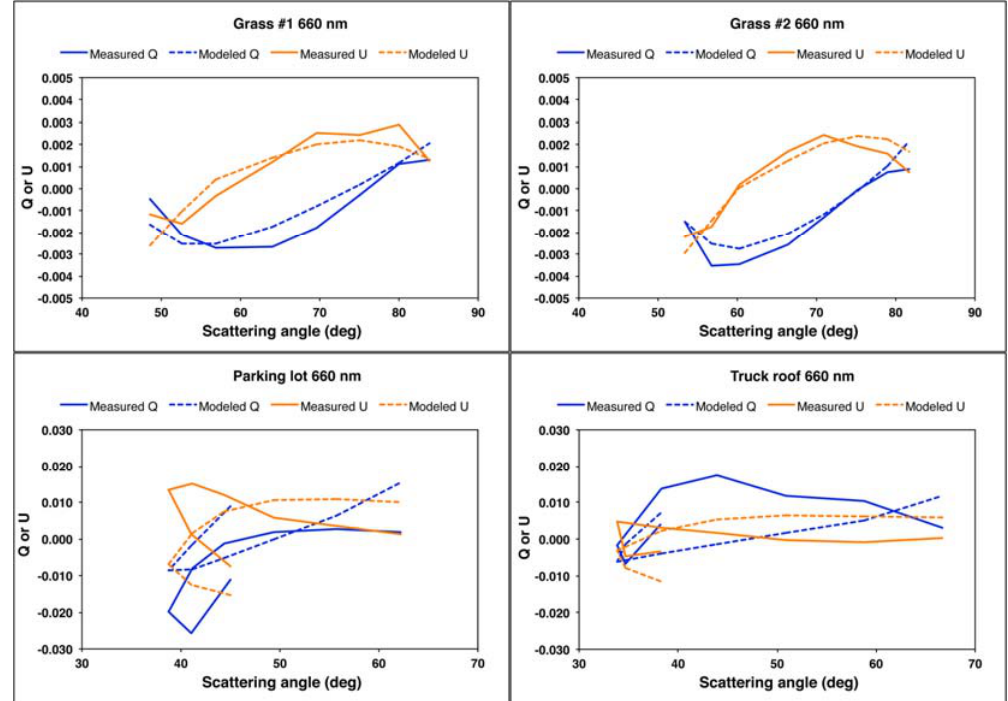
derived in Step pol